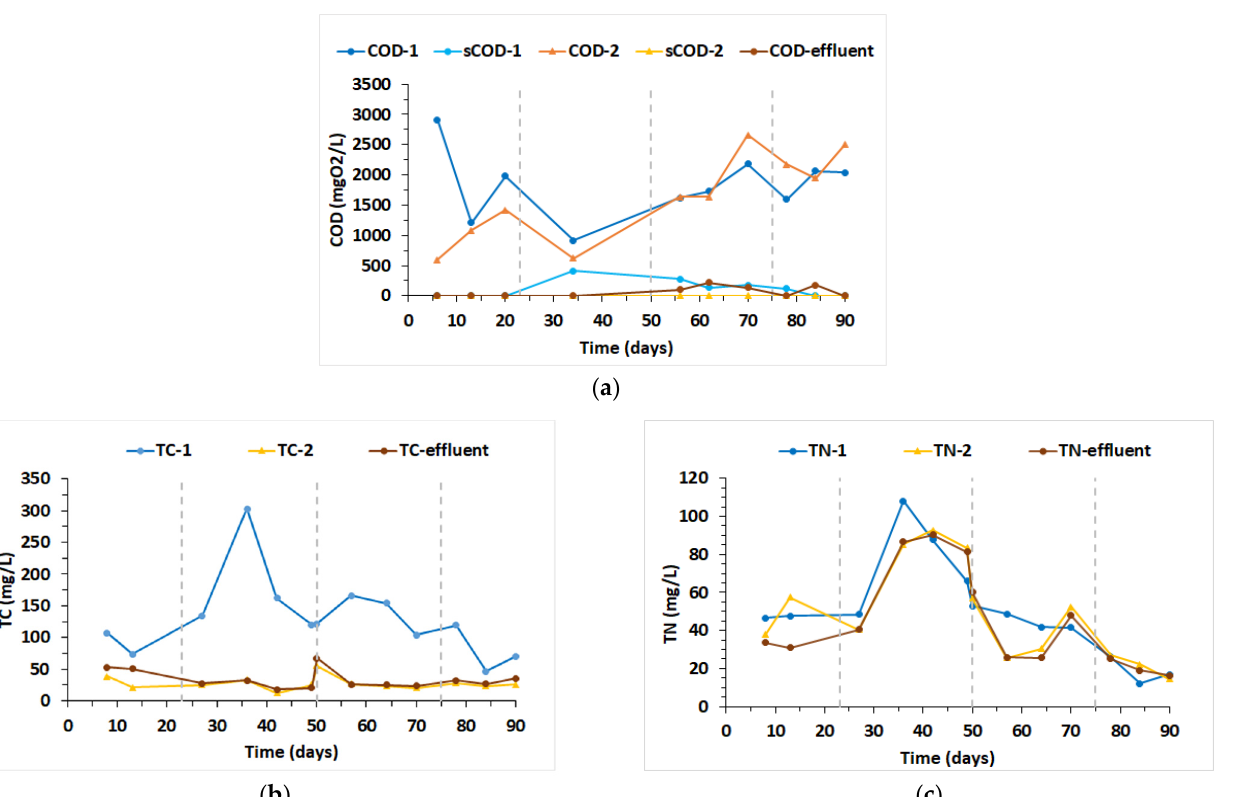
Figure 4. ( a ) Evolution of the COD and sCOD concentrations in the anaerobic reactor (1), the aerobic reactor (2), and the treated effluent. The values presented as 0 mgO 2 /L correspond to values <100 mgO 2 /L (below the limit of quantification). ( b ) Evolution of the TC concentrations in the anaerobic reactor (1), the aerobic reactor (2), and the treated effluent. ( c ) Evolution of the TN concentrations in the anaerobic reactor (1), the aerobic reactor (2), and the treated effluent.